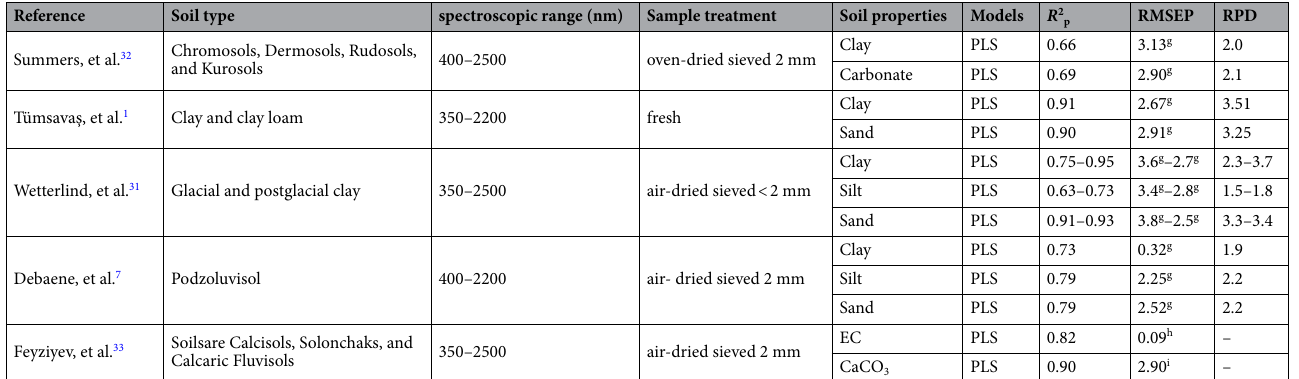
Table 1. A review of recent literature that used lab-based Vis–NIR spectroscopy for estimating some physicochemical properties of soil. CaCO 3 calcium carbonate, EC electrical conductivity, PLS partial least squares, R 2 p coefficient of determination in prediction, RMSEP root mean square error of prediction ( g %, h standard error dS.m −1 , i standard error g.kg −1 ), RPD residual prediction